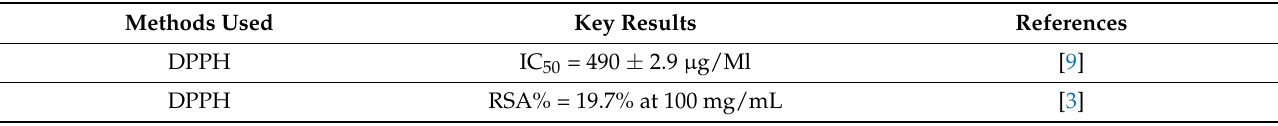
Table 3. Antioxidant effects of